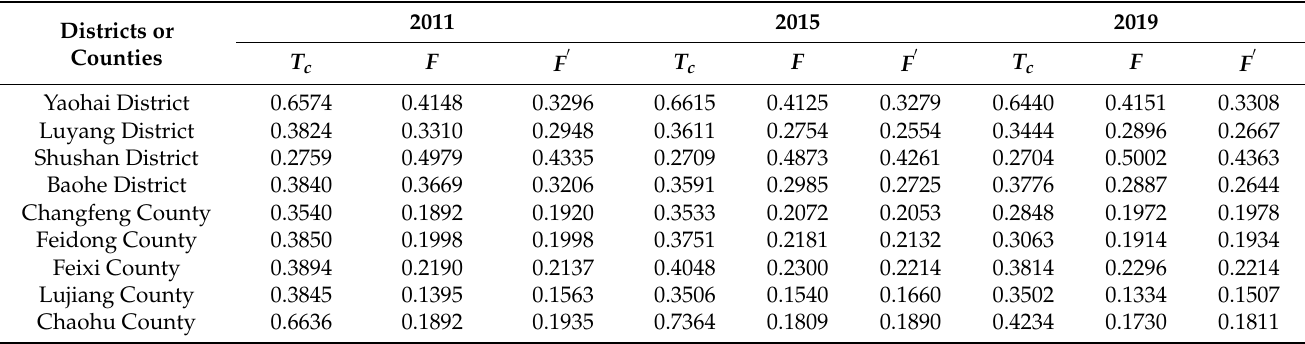
Table 4. Overall evaluation results of PLE function in all districts and